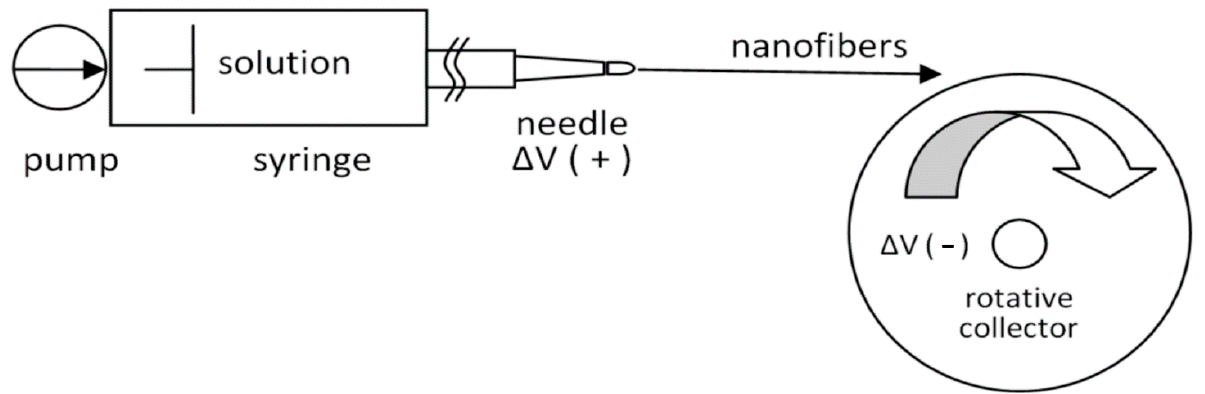
Figure 1. Electrospinning apparatus scheme.